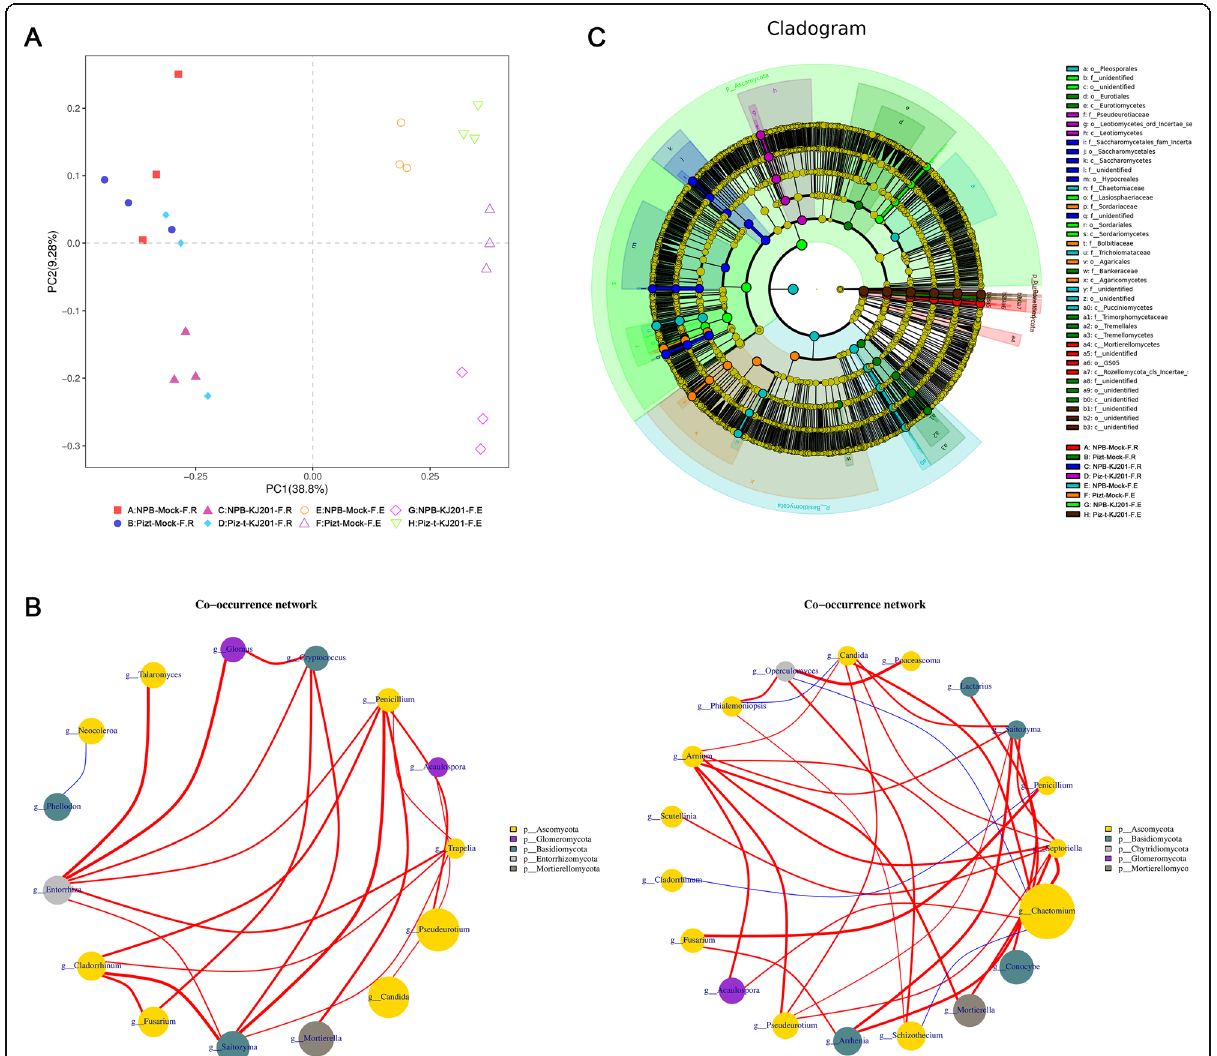
Fig. 4 Fungal communities are separable by rhizocompartment and endocompartment. a Principal component analysis of OTUs abundance data indicates that the largest separation between rhizocompartment and endocompartment is spatial proximity to the root (PC1) and the second largest source of variation is host genotype and inoculation (PC2). b Co-occurrence networks were constructed based on correlation analysis of taxonomic profiles. Connections were drawn between nodes that were significantly ( P < 0.01; Spearman ’ s rank correlation test) and highly correlated. The size and color of each node were proportional to the number of connections and module of the microbe, respectively. The colors of the links were mapping to the correlation (Red: positive correlation; Blue: negative correlation). c Cladogram indicating the phylogenetic distribution of fungal lineages associated with the rhizospheric and entospheric communities. The circles from inside to outside indicate fungal taxonomic levels from phylum to genus. Each small circle at each classification level represents a classification at that level, and each circle ’ s diameter is proportional to the taxon ’ s abundance. Yellow dots represent fungi not significantly varying in abundance among treatments. Biomarker fungi are coloured according to their correspondingly class colors on the right. Red nodes represent the fungal taxa that play an important role in the red group, the green nodes represent the fungal taxa that play an important role in the green group, which is applicable to the other circles. The names of the species in English letters are shown in the illustration on the